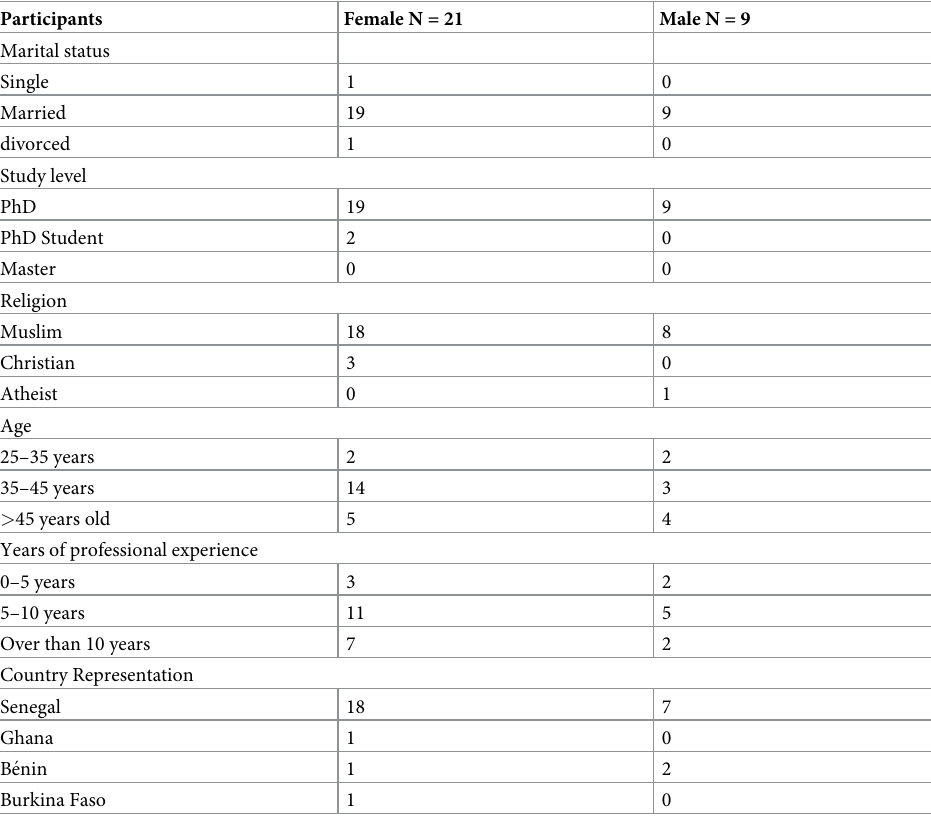
Table 2. Sex-disaggregated and sociodemographic characteristics of participants.